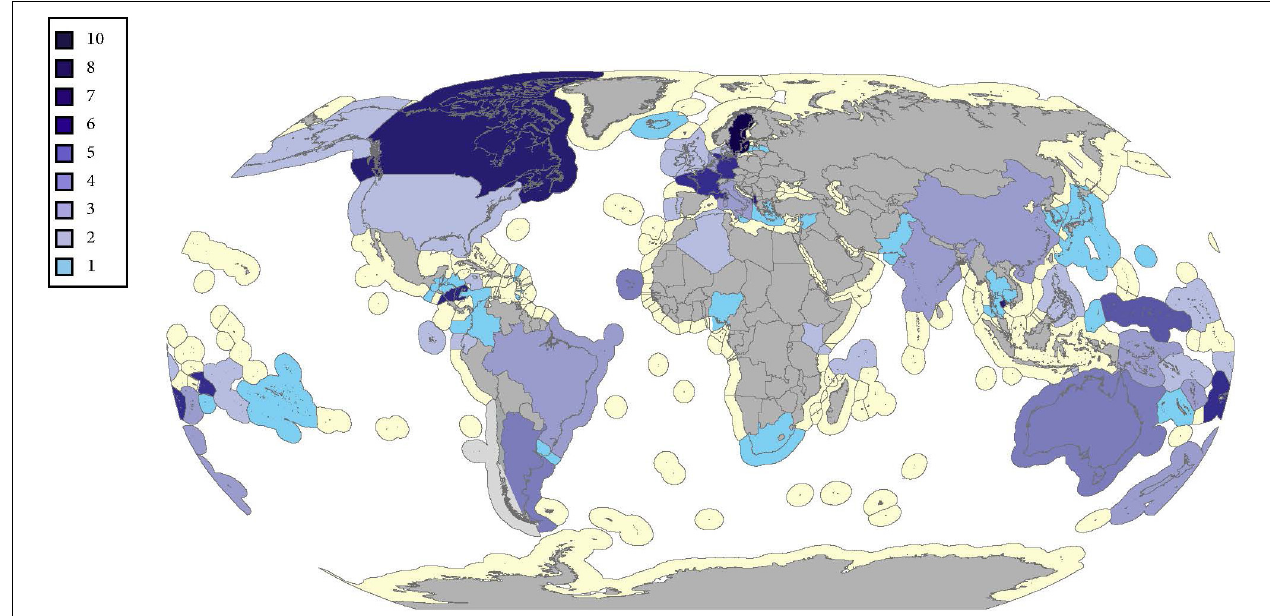
FIGURE 8 | Map of government’s MPA voluntary commitments (SDG 14.5) from 2017 UN Ocean Conference. This map shows proposed areas of new MPAs, within the country’s exclusive economic zone. N = 65 countries, not including the EU. 173 potential MPA sites were identified. Data collected from https://oceanconference.un.org/commitments/ as of November